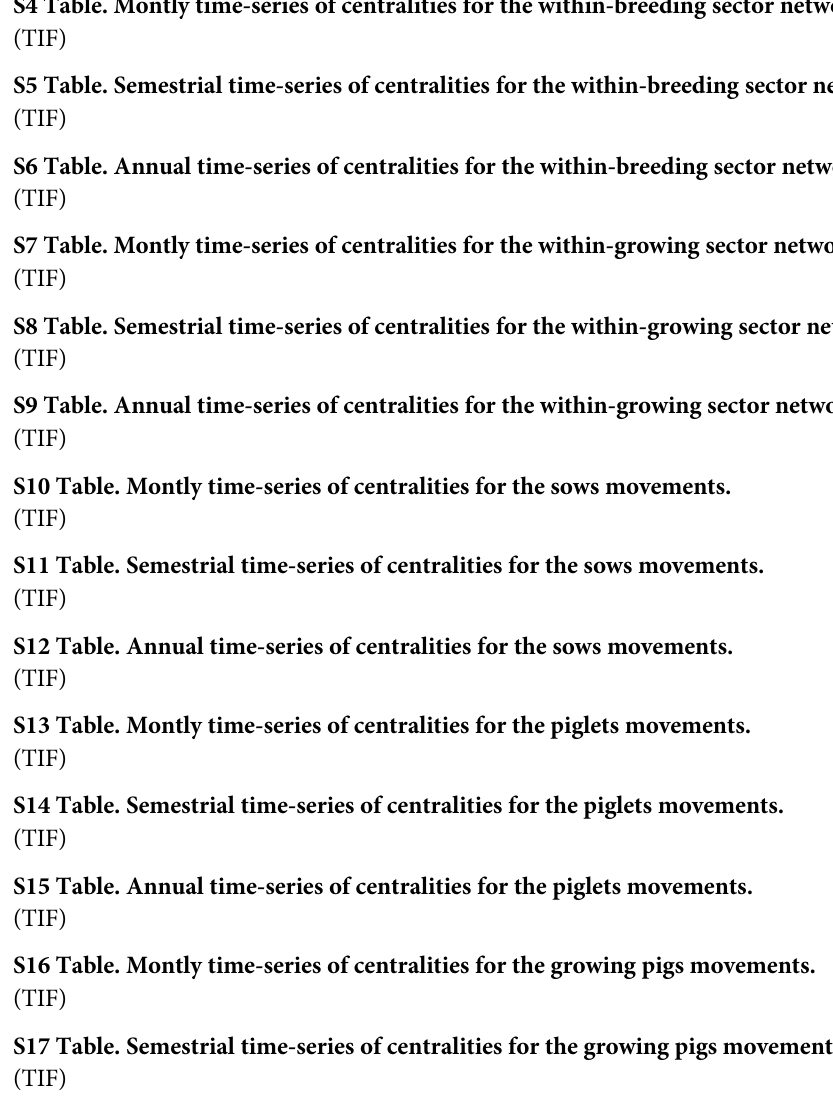
S1 Table. Montly time-series of centralities for the national swine industry network. (TIF) S2 Table. Semestrial time-series of centralities for the national swine industry network. (TIF) S3 Table. Annual time-series of centralities for the national swine industry network. (TIF) S4 Table. Montly time-series of centralities for the within-breeding sector network. (TIF) S5 Table. Semestrial time-series of centralities for the within-breeding sector network. (TIF) S6 Table. Annual time-series of centralities for the within-breeding sector network. (TIF) S7 Table. Montly time-series of centralities for the within-growing sector network. (TIF) S8 Table. Semestrial time-series of centralities for the within-growing sector network. (TIF) S9 Table. Annual time-series of centralities for the within-growing sector network. (TIF) S10 Table. Montly time-series of centralities for the sows movements. (TIF) S11 Table. Semestrial time-series of centralities for the sows movements. (TIF) S12 Table. Annual time-series of centralities for the sows movements. (TIF) S13 Table. Montly time-series of centralities for the piglets movements. (TIF) S14 Table. Semestrial time-series of centralities for the piglets movements. (TIF) S15 Table. Annual time-series of centralities for the piglets movements. (TIF) S16 Table. Montly time-series of centralities for the growing pigs movements. (TIF) S17 Table. Semestrial time-series of centralities for the growing pigs movements.